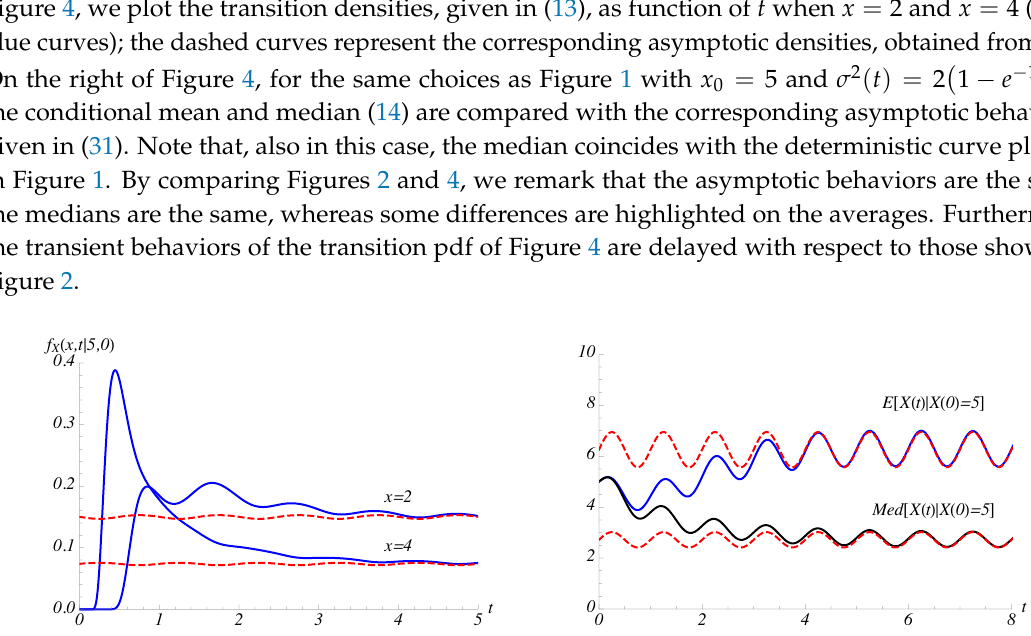
(cid:0) (cid:1) 2 1 − e − 1.2 t